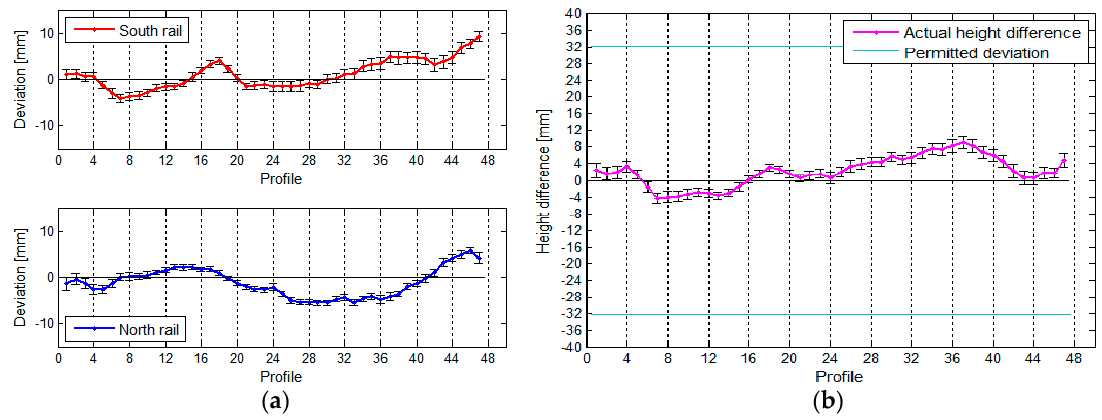
Figure 17. ( a ) The vertical deviations and ( b ) the height differences between the rails, with their standard deviations, for the crane in the TPP in Brestanica measured with TLS.